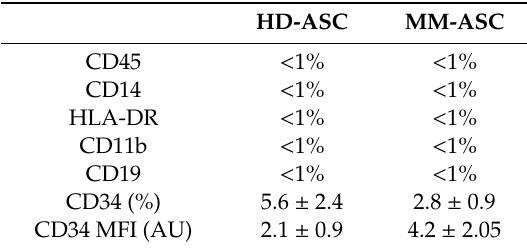
Table 1. Expression of hematopoietic markers in HD-ASC ( n = 6) and MM-ASC ( n = 11) at passage 2 (P2) of